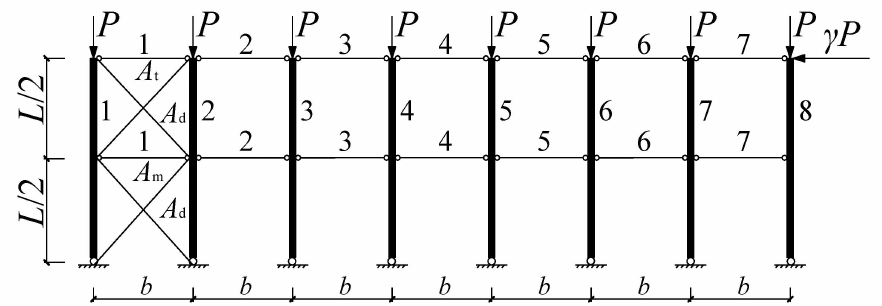
Figure 8. The analytical model under the most unfavorable horizontal load combination.